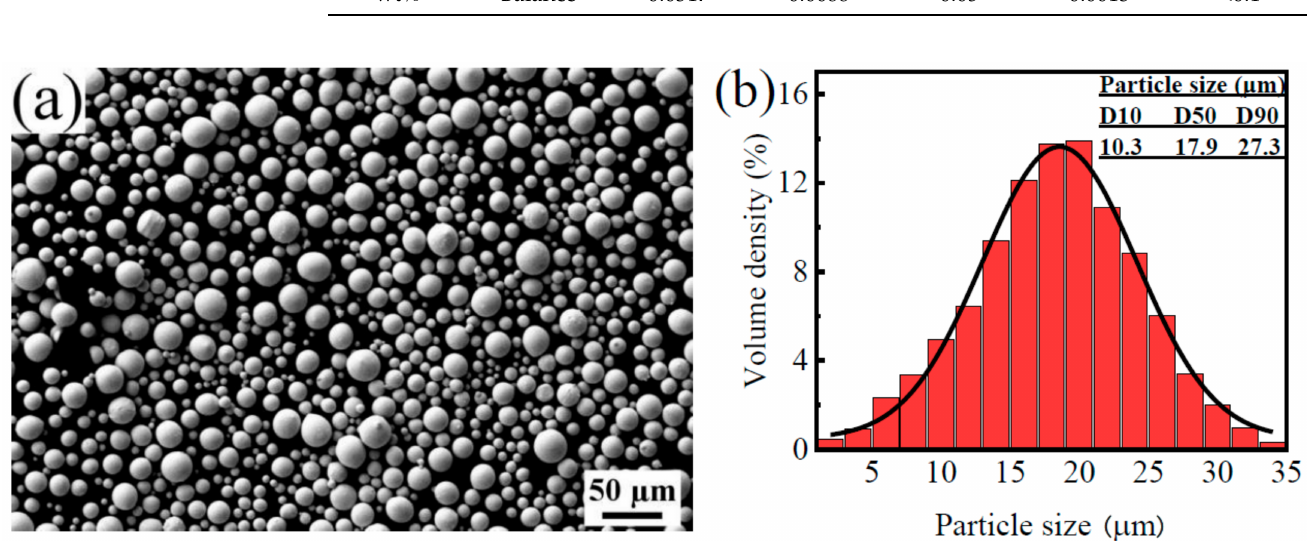
Figure 1. ( a ) Morphologies and ( b ) Particle size distributions of Ta